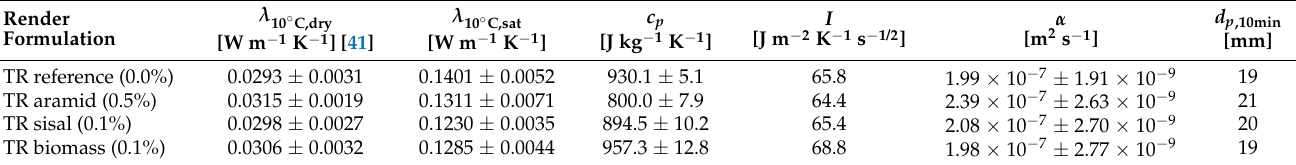
Table 3. Thermal properties result in synthesis.